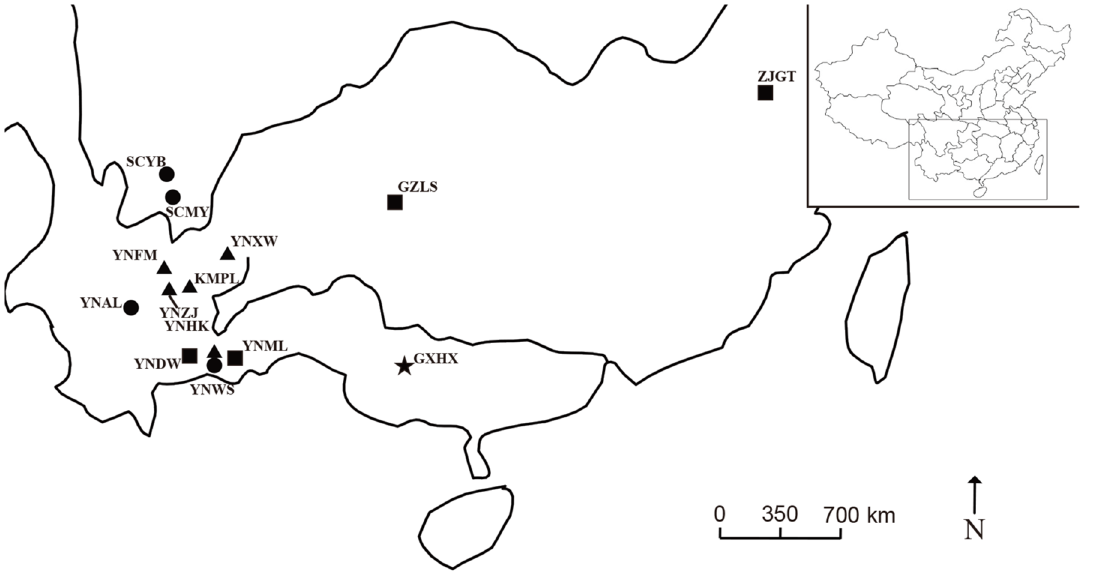
Fig 1. Map of sampling locations of Morella in China. Squares indicate Morella rubra ; triangles indicate M . nana ; dots indicate M . esculenta ; star indicates M . adenophora